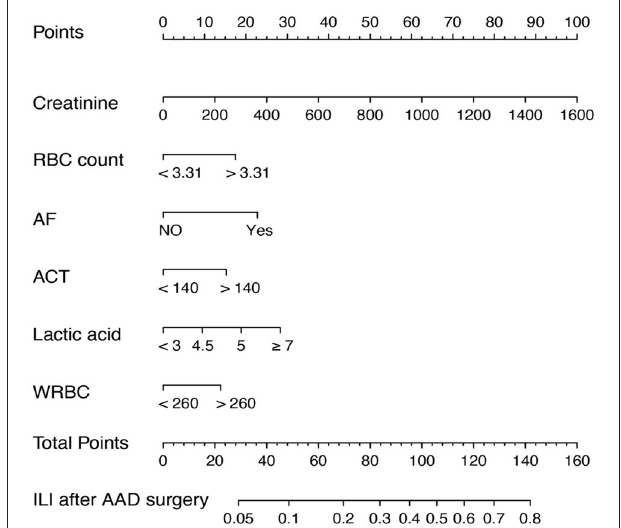
FIGURE 2 | Nomogram predicting ILI risk in patients after AAD surgery. The nomogram to predict the risk of ILI for patients after AAD surgery was created based on 6 independent prognostic factors. The value of each of variable was given a score on the point scale axis. A total score could be calculated by adding each single score, and we can estimate the probability of ILI by projecting the total score to the lower total point